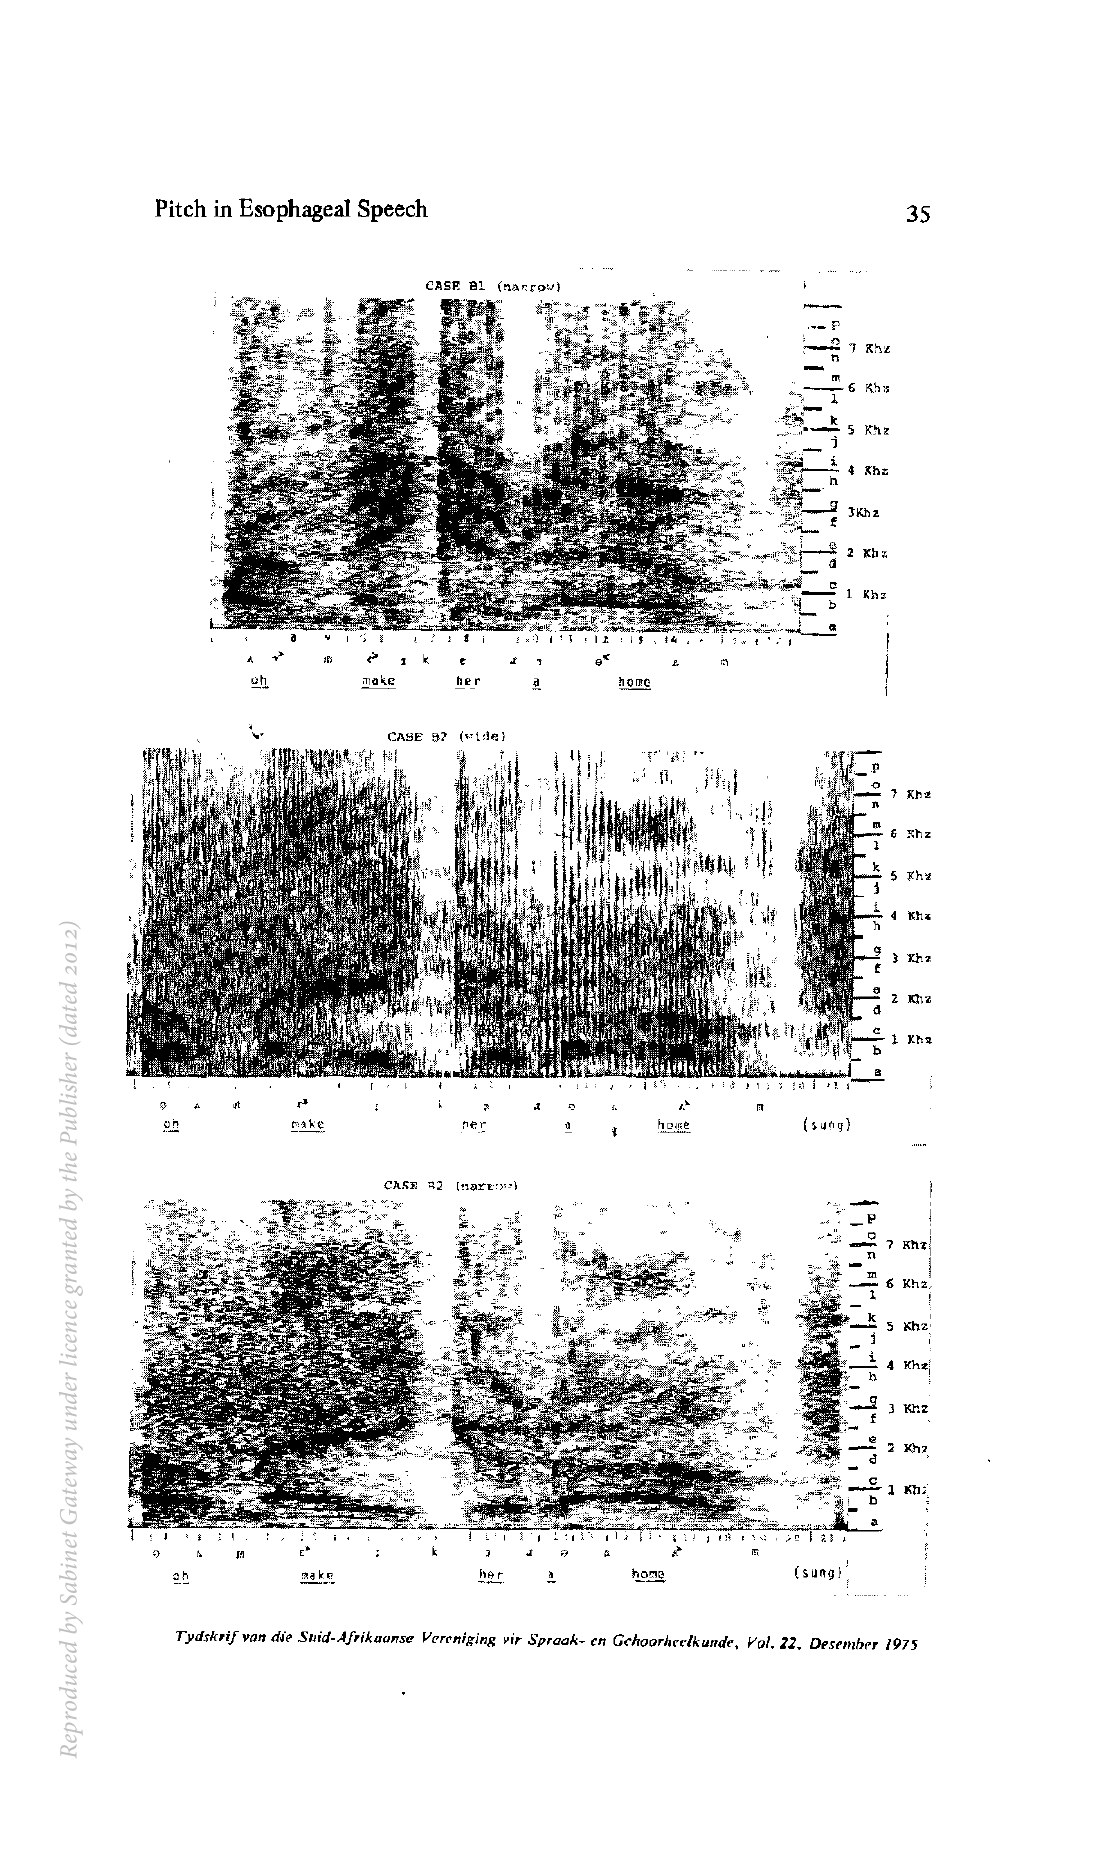
home (sung > * Tydskrif van die Suid-Afrikaanse Vereniging vir Spraak- en Gehoorheekde, Vol. 22, Deseber